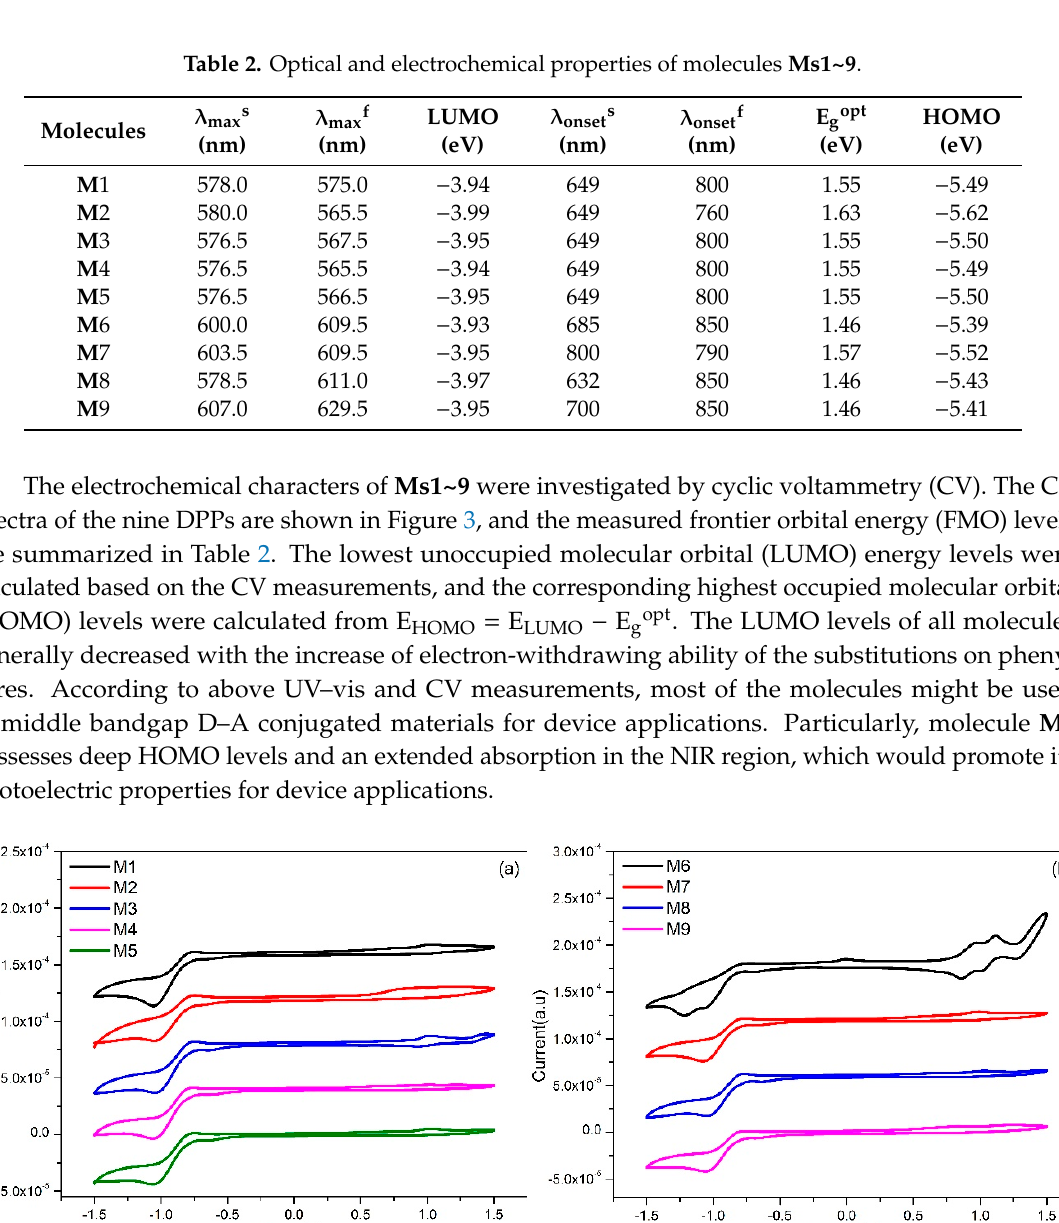
Table 2. Optical and electrochemical properties of molecules Ms1~9 .